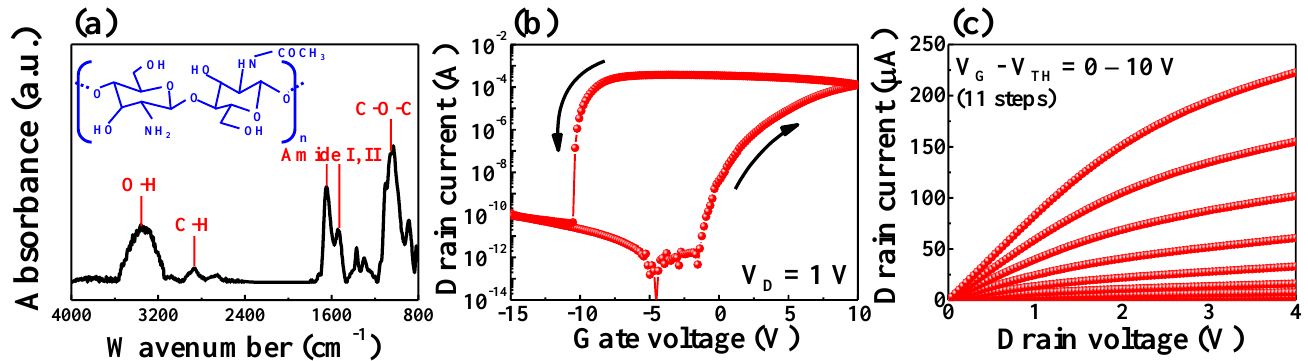
Figure 2. a) Fourier transform infrared spectrum of solid-state chitosan electrolyte, (b) transfer Figure 2. ( a ) Fourier transform infrared spectrum of the solid-state chitosan electrolyte; ( b ) transfer curves (I D – V G ) in double-sweep mode, and (c) output curves (I D – V D ) of chitosan/Ta 2 O 5 hybrid die- 160 curves (I D –V G ) in double-sweep mode; and ( c ) output curves (I D –V D ) of the chitosan/Ta 2 O 5 hybrid lectric EDLT. dielectric